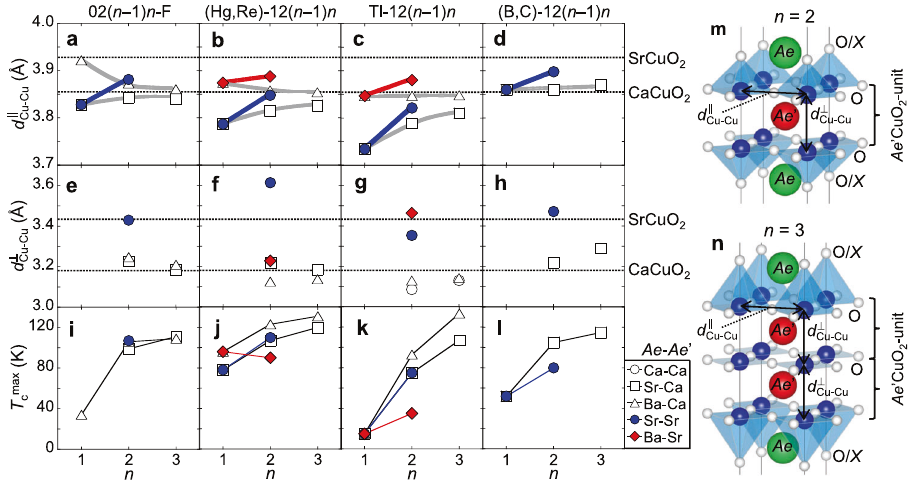
Fig. 3 Comparison of the characteristic structural parameters and their T c for n in the typical homologous series of cuprates with the tetragonal Þ , e – h out-of-plane Cu – Cu distance ð d ? Þ , and i – l T structure. a – l The change in the a – d in-plane Cu – Cu distance ð d k c in the optimally doped region Cu (cid:2) Cu Cu (cid:2) Cu of the apical F, (Hg,Re)-, Tl-, and (B,C)-based cuprates, with respect to n . The thick solid line and curves are a visual guide. The upper and lower horizontal ð d ? Þ for the in fi nite-layered SrCuO dotted lines represent the values of d k 2 and CaCuO 2 , respectively. For the Ca-free 0212-F compound, T c of the Cu (cid:2) Cu Cu (cid:2) Cu fl uorinated sample is plotted. Part of data were acquired from the literature 10,18,24,34,39,42,44,45 . The closed circle and diamond markers represent the data for Ca-free cuprates in the Ae = Sr and Ba cases, respectively. m , n Magni fi ed views near the CuO 2 layers in the crystal structure of cuprates with m n = 2 and n n = 3. Each atom corresponds to Ae , Ae 0 , Cu, and O or O/ X in order from the largest ball. The horizontal and vertical double arrows represent lengths for d k and d ? , Cu (cid:2) Cu Cu (cid:2) Cu Fig. 3a – l compare these parameters for each type of cuprate. k The former distance, d , corresponds to the a -axis length (see Cu (cid:2) Cu Fig. 3m and n). Since the structure of the multilayered cuprate is considered as a hybrid of the in fi nite-layered and single-layered (indicated by the ver- ( n = 1) phases, the latter distance, d ? Cu (cid:2) Cu tical double arrows in Fig. 3m and n), was de fi ned by dividing the obtained c -axis length subtracted from that of the 0201 phase, by value calculated based the corresponding n . Note that the d ? Cu (cid:2) Cu on this method may contain a certain amount of uncertainty. However, according to a previously reported data of the crystal- lographic parameters of (Hg,Re)Ba 2 Ca n − 1 Cu n O 2 n + 2 + δ 24 , the lengths are 3.156 and 3.153 Å for n = 2 and n = 3 genuine d ? Cu (cid:2) Cu